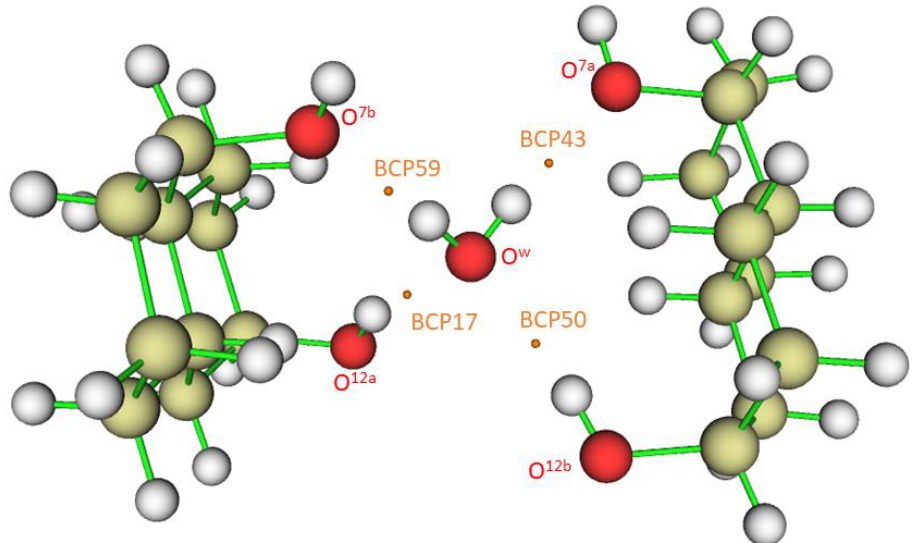
Figure 5. Bond critical points (BCP) and hydrogen bond critical points (HBCP) obtained for the complex O 12a -H ... O w -H ... O 7a //O 12b -H ... O w -H ... O 7b . HBCPs are identified with numbers 17, 43, 50, and 59.